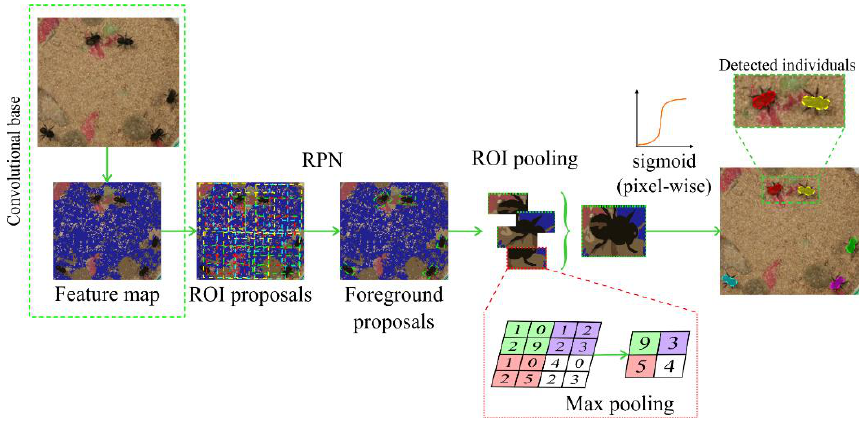
Figure 2. Diagram depicting the operations involved in instance segmentation used in Ethoflow for animal behavior assessments in heterogeneous environments. RPN: region proposal network; ROI: box surrounding the object of interest.